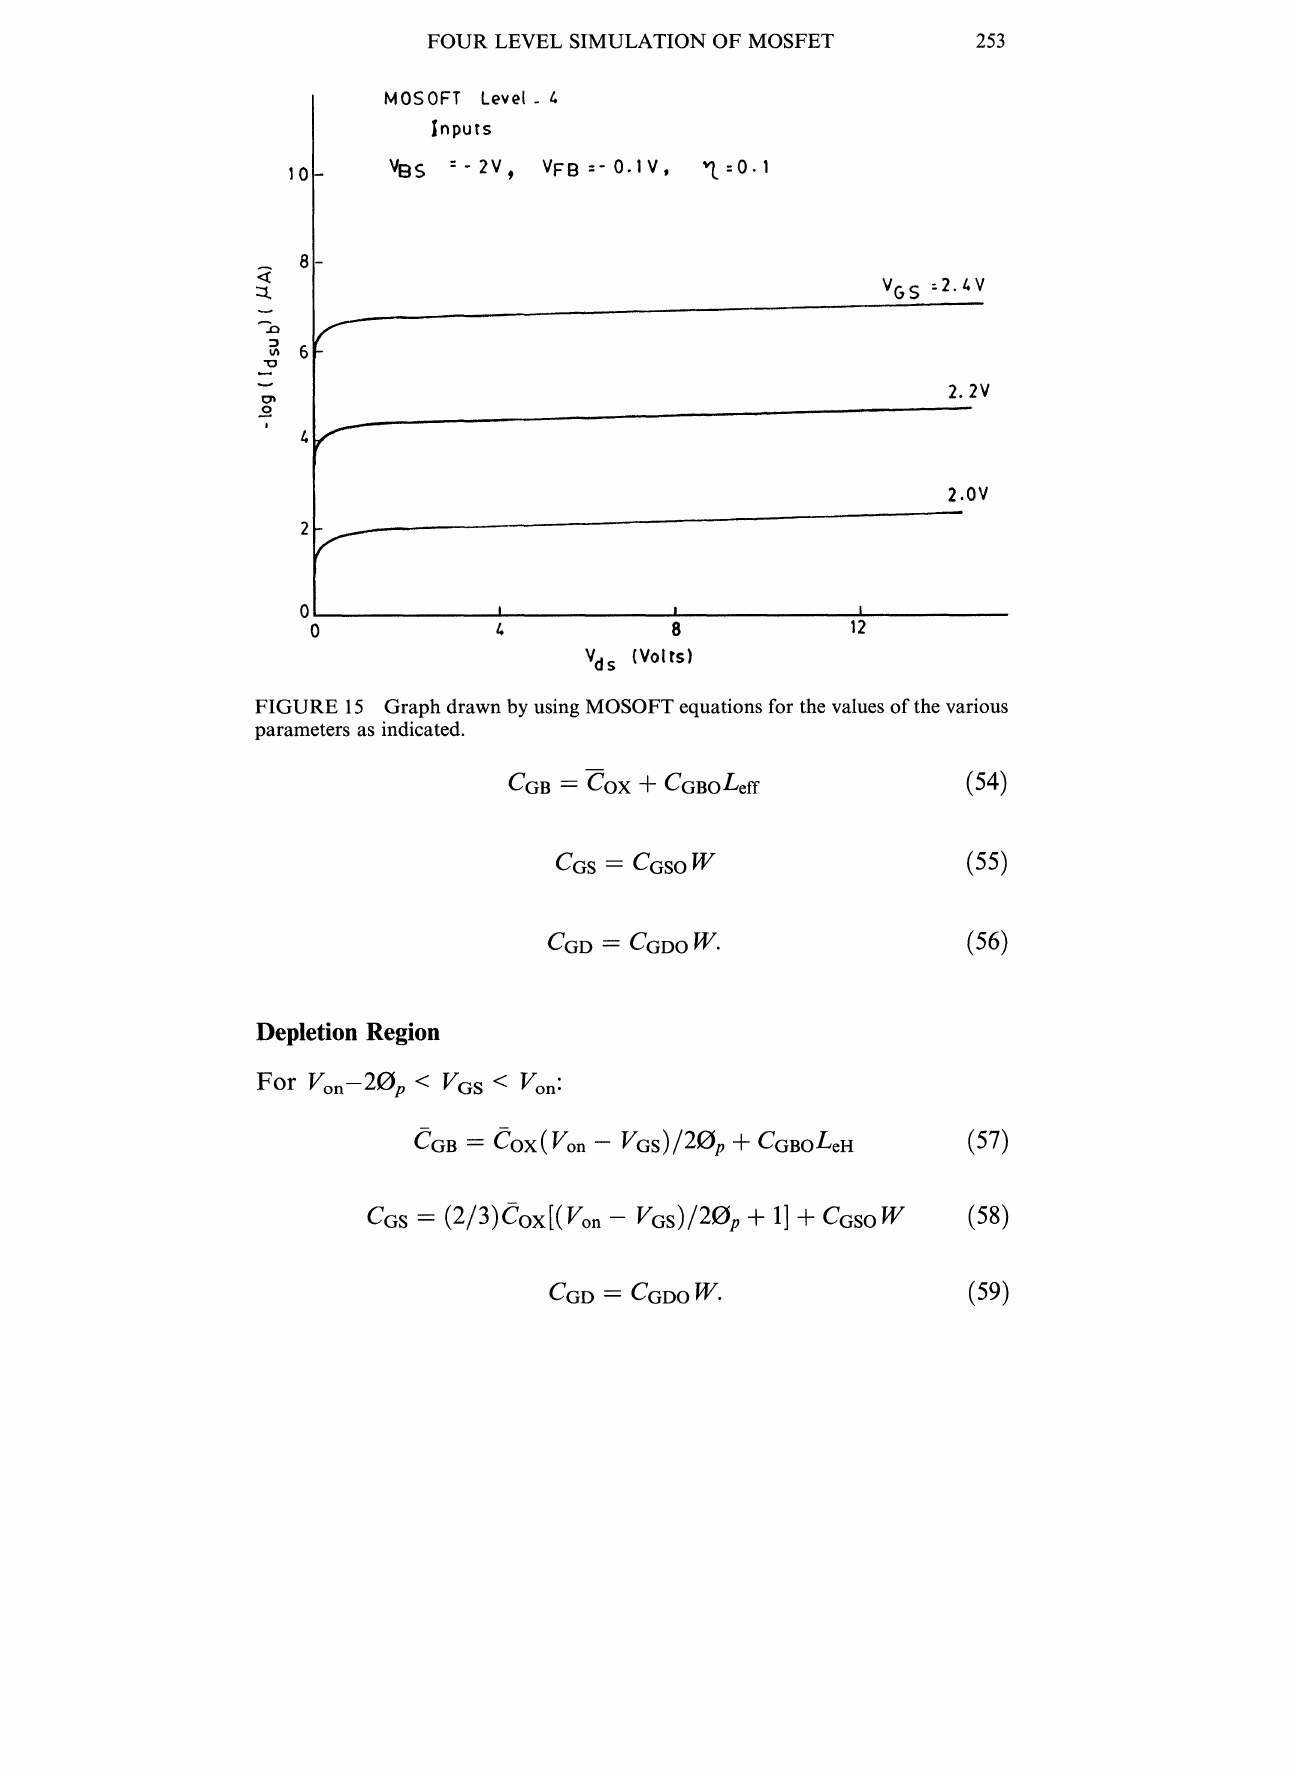
FIGURE 15 Graph drawn by using MOSOFT equations for the values of the various parameters as